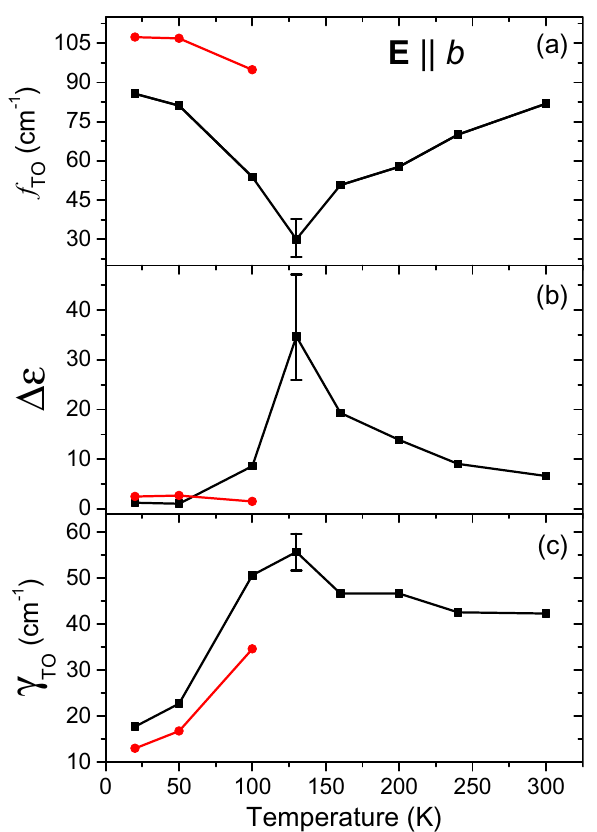
Figure 4. Temperature dependence of oscillator parameters characterizing the soft phonon in the E (cid:31) b polarization, obtained by fitting the IR reflectivity spectra using Eqs. (1), (2). ( a ) oscillator frequency, ( b ) oscillator strength �ε , ( c ) oscillator damping γ TO . Black symbols: dominant phonon, red: weaker mode arising below T c2 due to symmetry lowering. The lines are guides for the eye only. Errors in determining the parameters are approximately equal to the symbol size, except at T = 130 K where they are shown by the error bars; note that no THz data was available for that